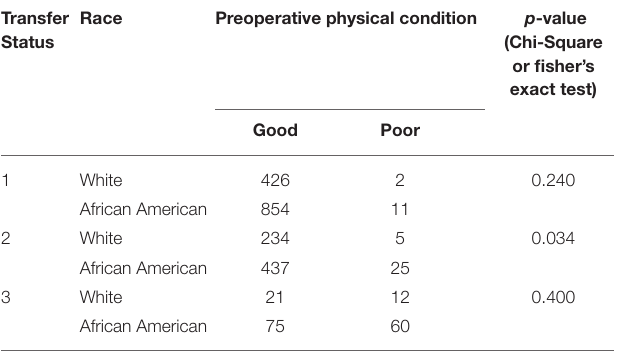
TABLE 2 | Comparison of African American and White children by their preoperative physical condition adjusted by transfer status.